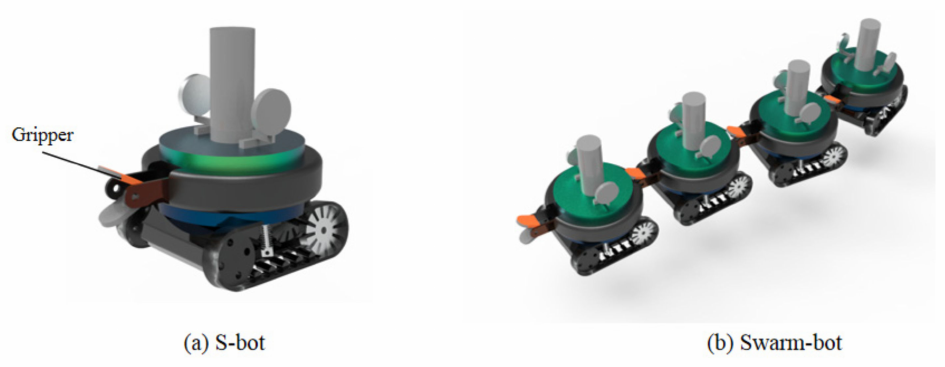
Figure 3. S-bot and swarm-bot self-reconfigurable modular